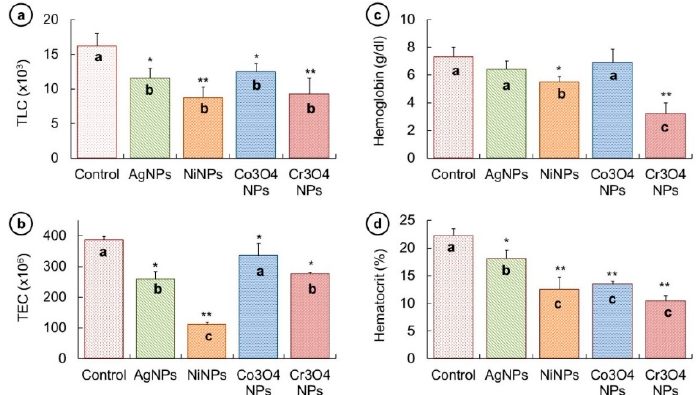
Figure 7. ( a ) Total number of leukocytes (TLC) was significantly lower in all fish groups treated with NPs than the control group. ( b ) The total number of erythrocytes (TEC) was not significantly different in control and Co 3 O 4 NP-treated groups but was significantly decreased in other groups. ( c ) The hemoglobin content was significantly reduced in NiNPs and Cr 3 O 4 NP-treated groups. ( d ) The hematocrit % was significantly dropped in all NP-treated groups. Columns showing different letters (a, b, and c) are significantly different, (* p < 0.05) (** p < 0.01).